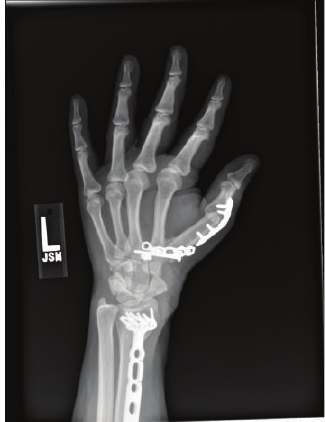
Figure 7: Postoperative X-ray of the left hand.